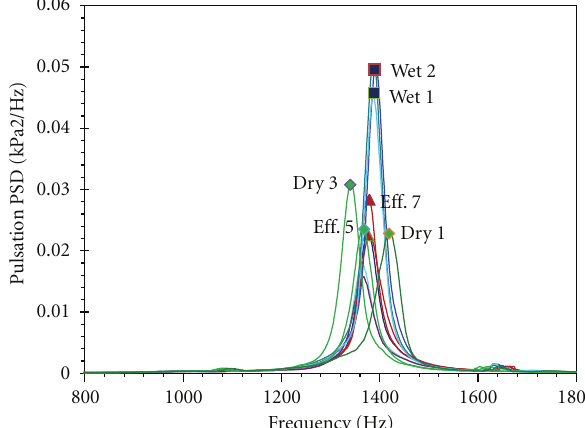
Figure 15: Expanded scale pulsation PSD spectra at 55000 RPM to examine levels near 1400